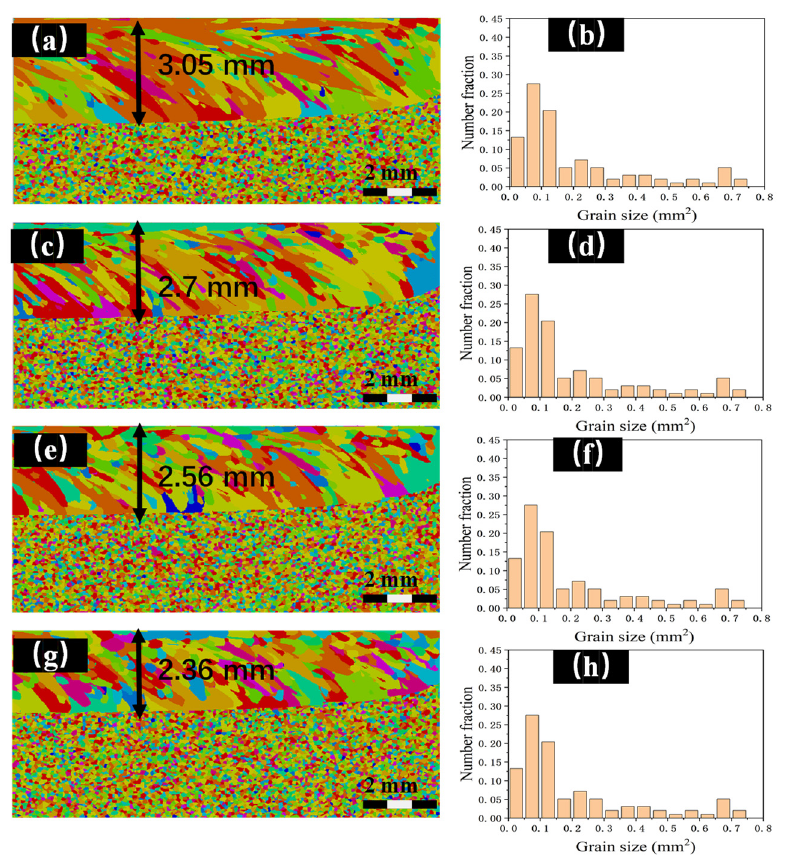
Figure 13. Grain morphology and size at different laser scanning speeds: ( a , b ) V = 50 mm/min; ( c , d ) P = 100 mm/min; ( e , f ) P = 150 mm/min; ( g , h ) P = 200 mm/min.